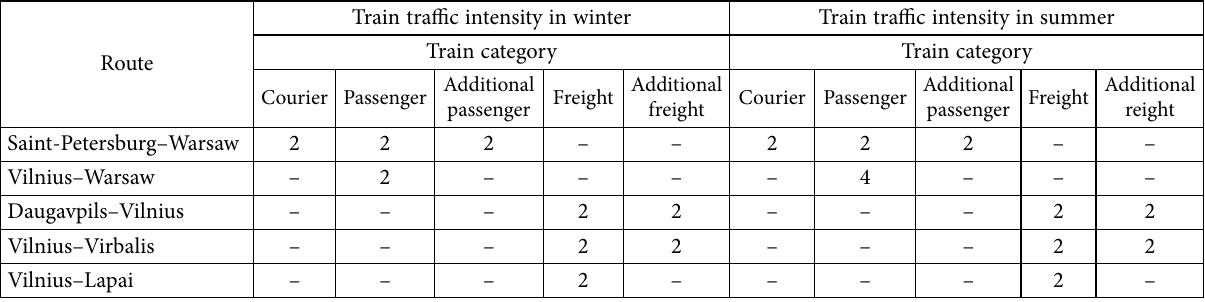
Table 3. Traffic intensity of Saint-Petersburg–Warsaw railway in 1865 (trains/day) (Žeimantas 2003)